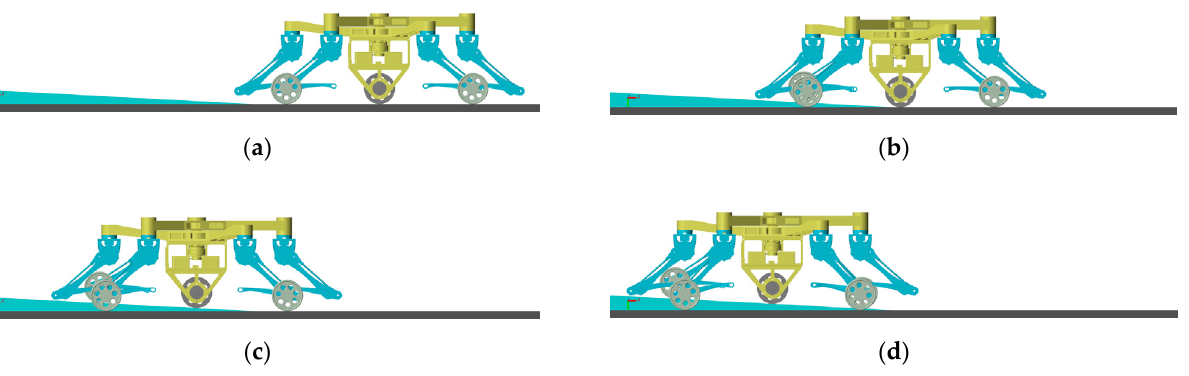
Figure 18. Simulation of wheeled motion (unilateral passive wheels and active wheel on slope). ( a )